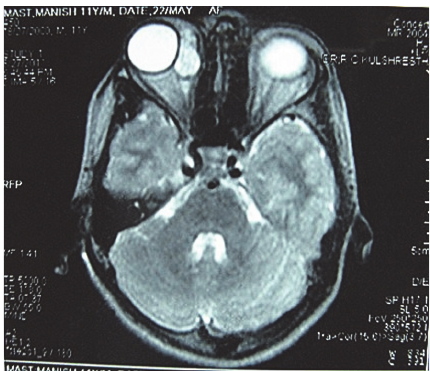
Figure 3: MRI scan of orbit MRI of the orbit revealed a well-defined mass of approximately 23 × 13mm along the medial rectus muscle.